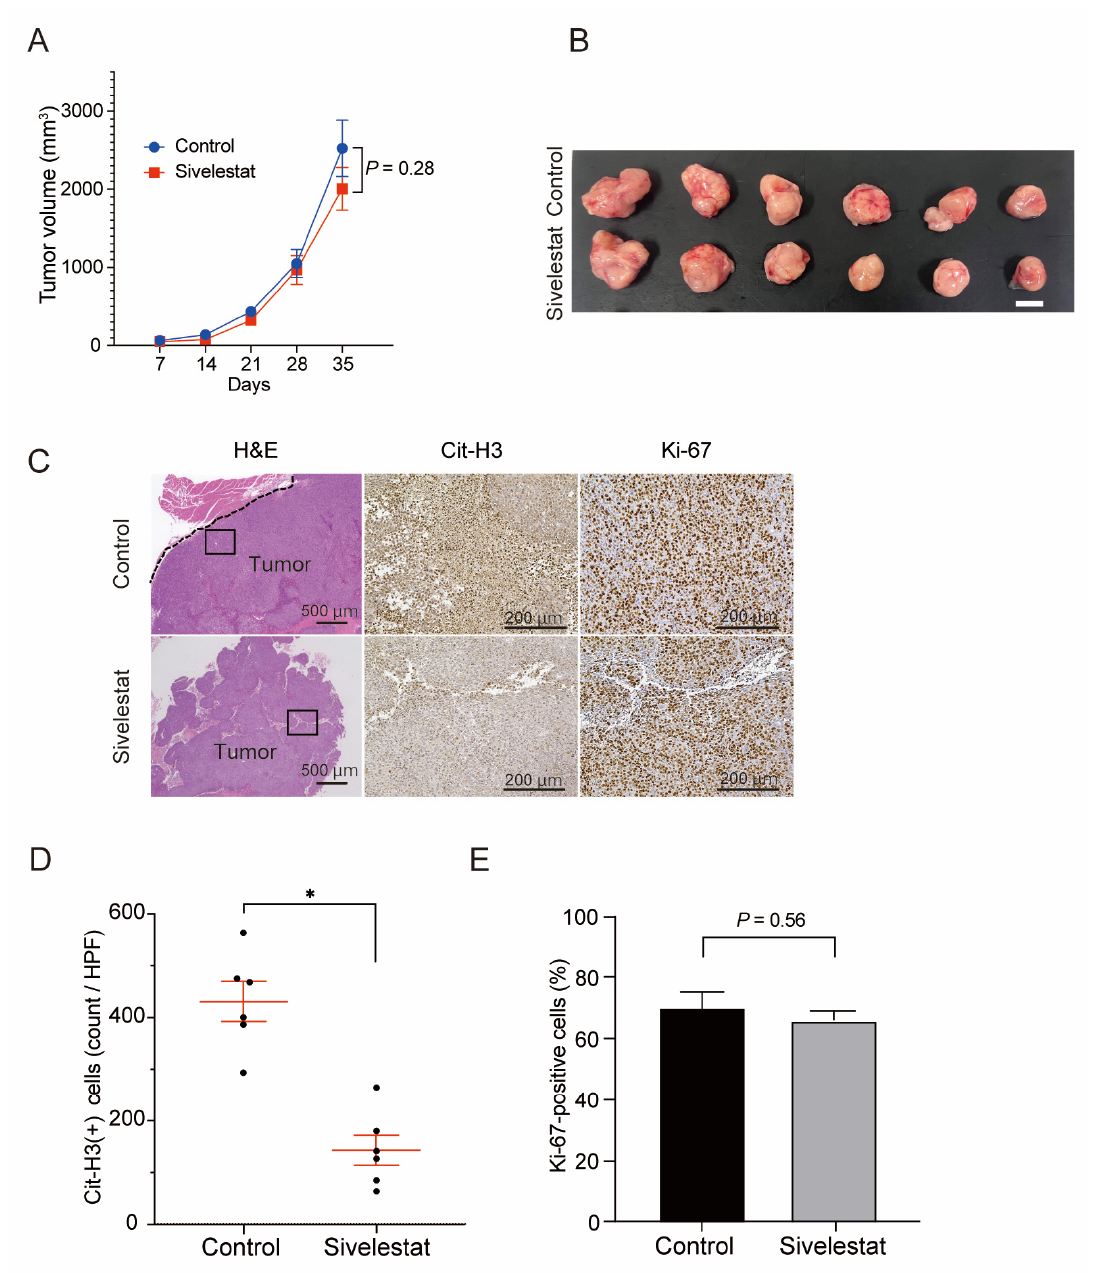
Figure 4. The suppression of NET formation by NE inhibitors had no effect on the growth of subcutaneous implanted tumors of CRC cells in vivo. ( A ) Growth curves of the subcutaneous transplanted tumors of HCT116 in the KSN/slc nude mice treated with sivelestat (10 mg/kg) or vehicle control. Mean: bars ± SEM. n = 6 tumors in each group. p values calculated with Student’s t -test. ( B ) Representative macroscopic images of the subcutaneous transplanted tumors of HCT116 cells dissected from KSN/slc nude mice treated with sivelestat (10 mg/kg) or vehicle control on day 35. Scale bars, 10 mm. ( C ) IHC staining for H&E, Cit-H3 and Ki-67 in subcutaneous transplanted tumors. Representative images are shown (H&E: scale bars, 500 µ m. Cit-H3, Ki-67: scale bars, 200 µ m). ( D , E ). Quantification of Cit-H3-positive cells ( D ) and percentage of Ki-67-positive cells ( E ) in the IHC staining of xenograft tumors. Mean: bars ± SEM. n = 6 tumors in each group. * p < 0.05 with Student’s t